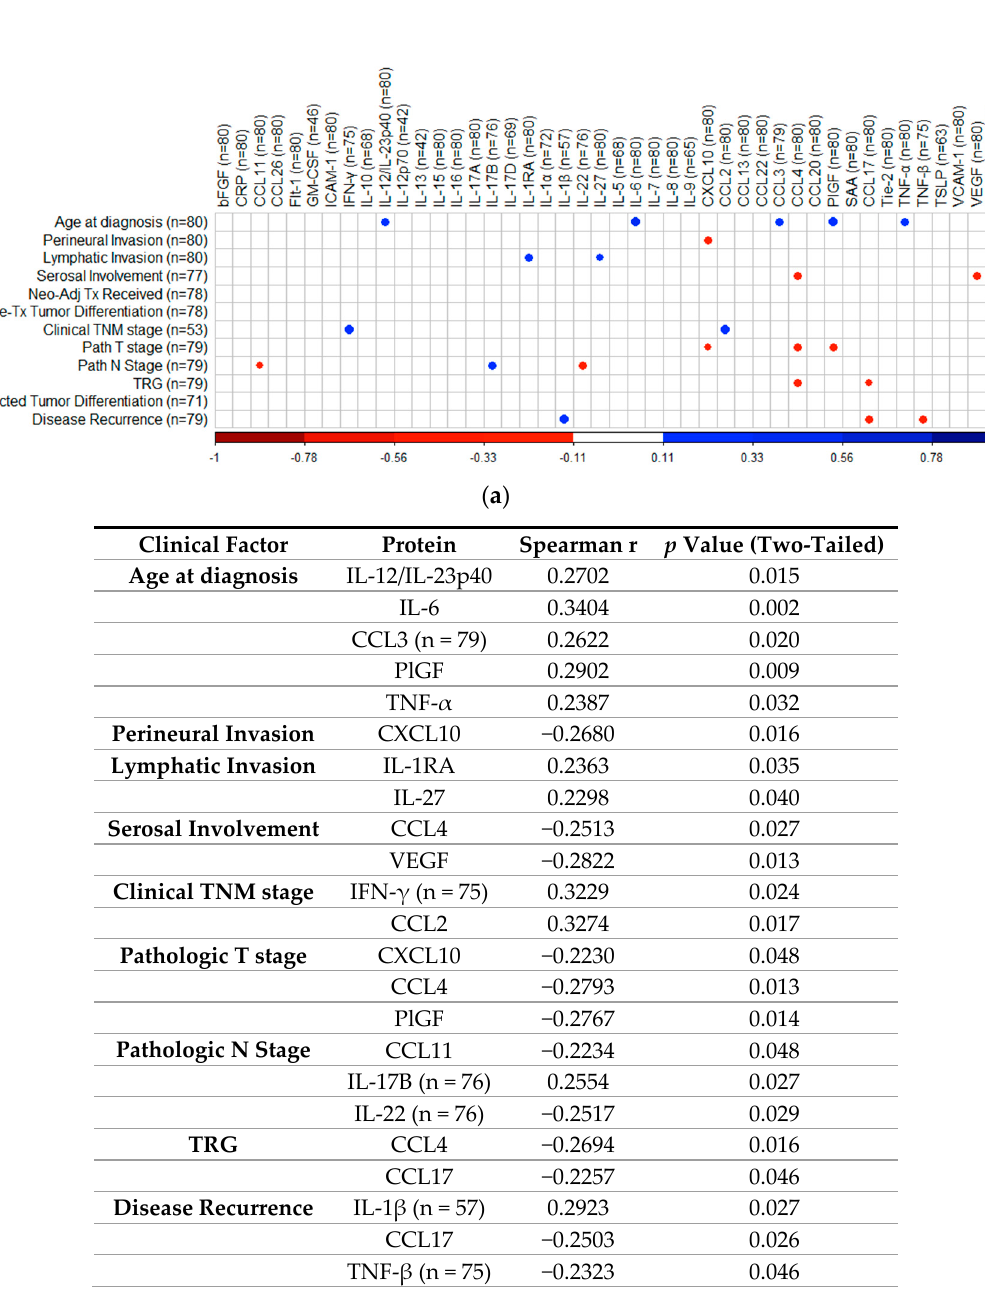
Figure 7. Correlation of cytokine levels with clinical parameters. ( a ) CorrPlot illustrating positive correlations identified between age at diagnosis with IL-12/IL-23p40, IL-6, CCL3, PlGF, and TNF- α , lymphatic invasion with IL-1RA and IL-27, clinical TNM stage with IFN- γ and CCL2, pathologic N stage with IL-17B and disease recurrence with IL-1 β . Negative correlations also illustrated were identified between perineural invasion with CXCL10, serosal involvement with CCL4 and VEGF, pathologic T stage with CXCL10, CCL4, and PlGF, pathologic N stage with CCL11 and IL-22, TRG with CCL4 and CCL17 and disease recurrence with CCL17 and TNF- β . ( b ) Table summarizing correlation values including Spearman r and p -values. Cohort n = 80, unless stated otherwise. All reported p values were also adjusted for false discovery rate using the Holm–Bonferroni method. TNM = Tumor Node Metastasis, TRG = Tumor Regression Grade. IL = Interleukin, PlGF = Placental Growth Factor, TNF = Tumor Necrosis Factor, VEGF = Vascular Endothelial Growth Factor, IFN = Interferon.